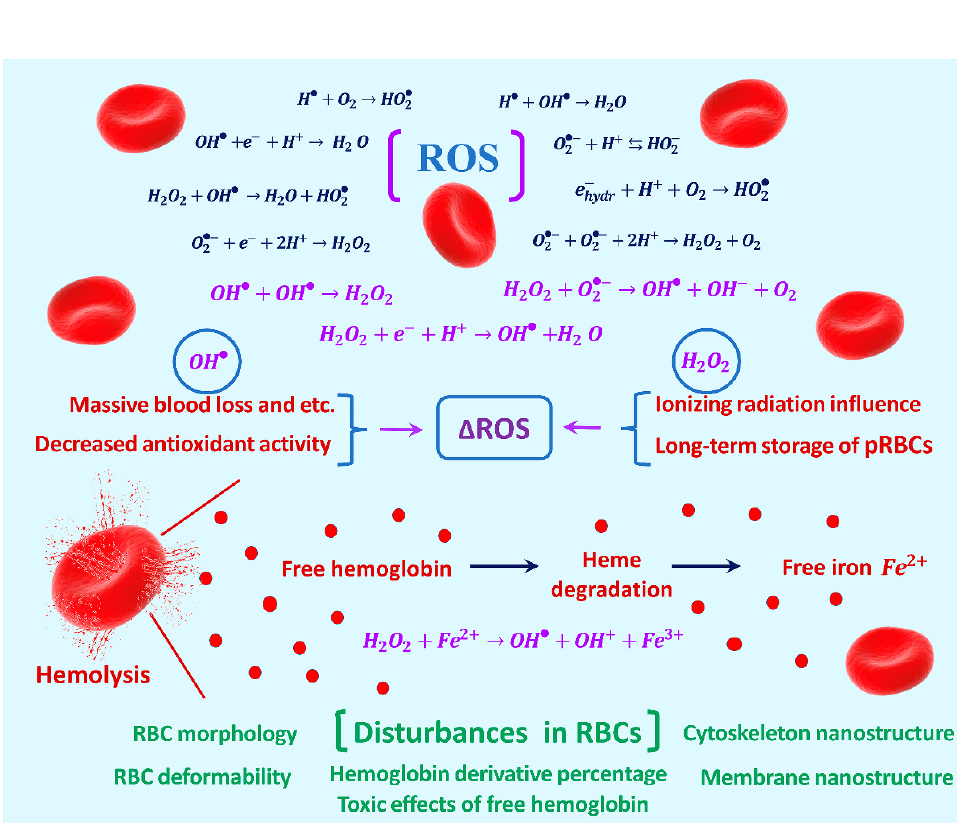
Figure 1. Patterns of chemical reactions between ROS. Formation of additional ∆ ROS as a result of various influences on RBCs. Reactions involving OH • leading to the formation of H 2 O 2 and vice versa are highlighted in purple. A special role is played by Fenton’s reaction of H 2 O 2 interacting with free iron Fe 2 + , which occurs during hemolysis of RBCs. As a result, additional